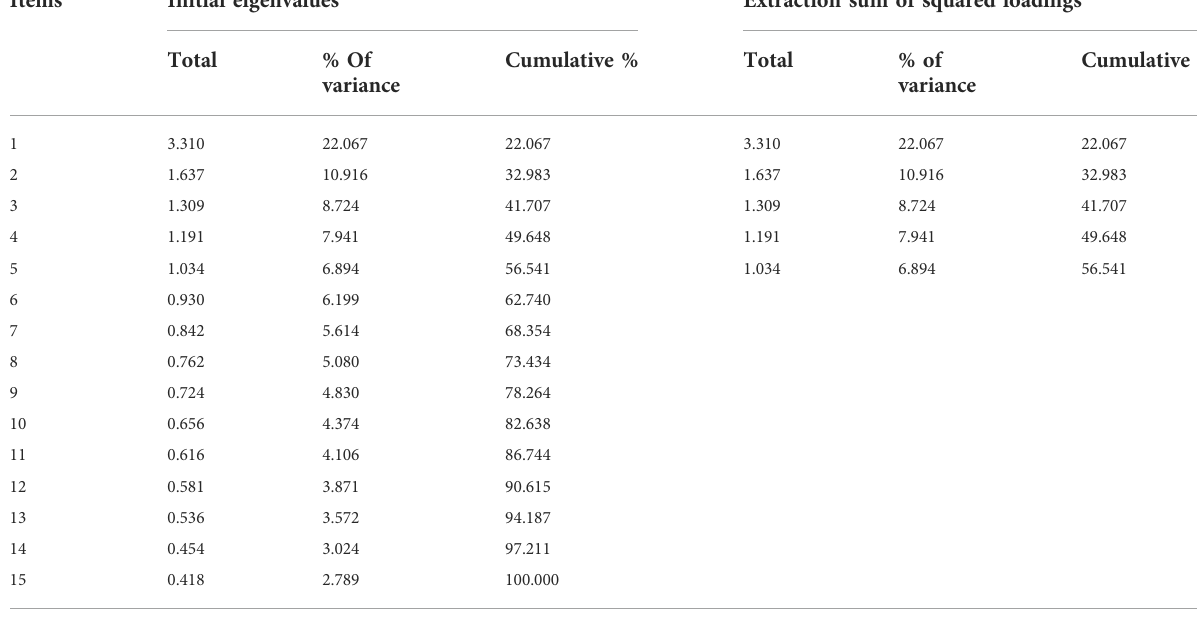
TABLE 5 Explained variance test.